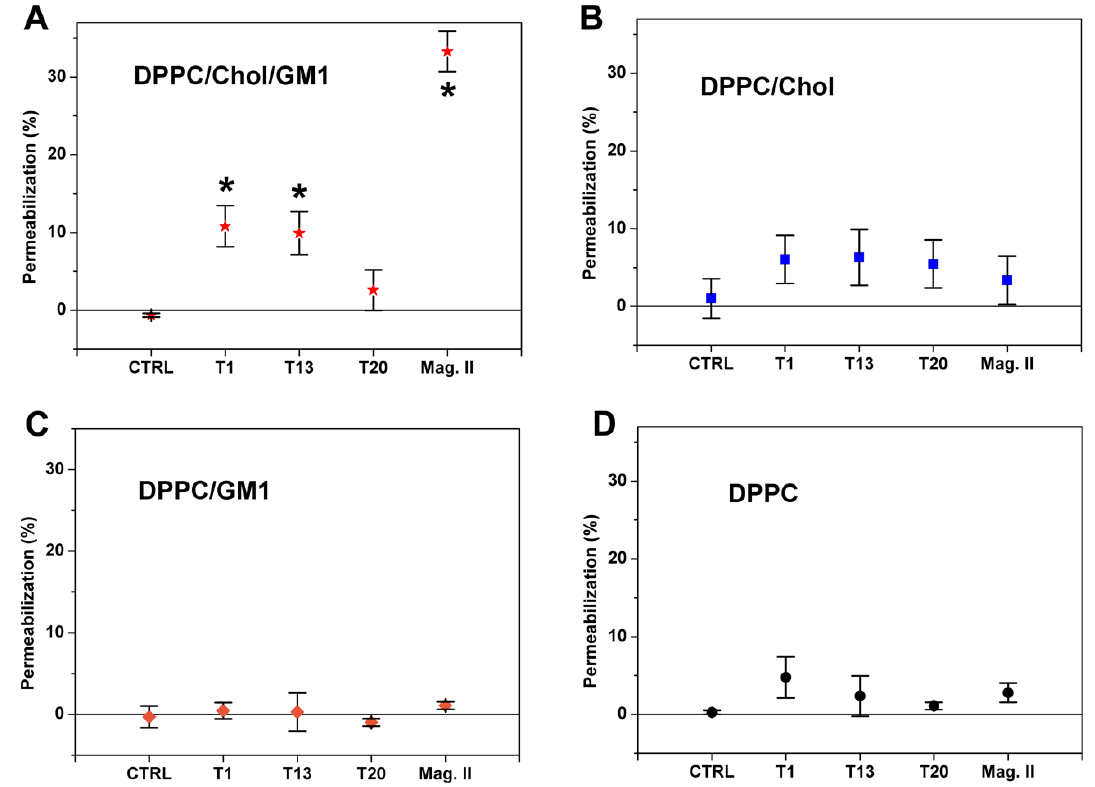
Figure 3. Membrane permeabilization induced by sCT solutions (13 µM) representative of the “Lag-phase” (T1), “Growth-phase” (T13) and “Saturation-phase” (T20) in the four types of liposomes: DPPC/Chol/GM1 ( A ), DPPC/Chol ( B ), DPPC/GM1 ( C ) and DPPC ( D ). The effects induced by Magainin II (Mag. II) at 13 µM in the same membrane models, are also reported. CTRL represents the permeabilization in the plain liposomes, error bars the standard errors ( N = 5) and * p < 0.05.